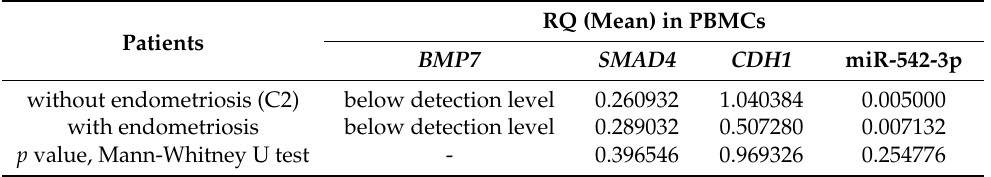
Table 1. The expression levels (mean RQ values) of the studied genes and miR-542-3p in the PBMCs